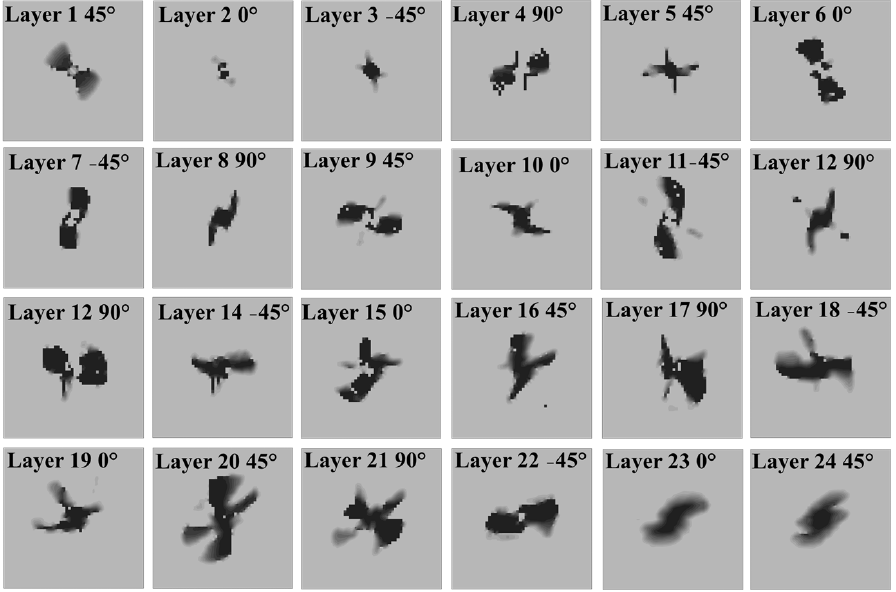
Figure 5. Layer ‐ by ‐ layer prediction of the matrix damage area, layer 1 being the impact side and Figure 5. Layer-by-layer prediction of the matrix damage area, layer 1 being the impact side and layer 24 being the rear side of the specimen. layer 24 being the rear side of the